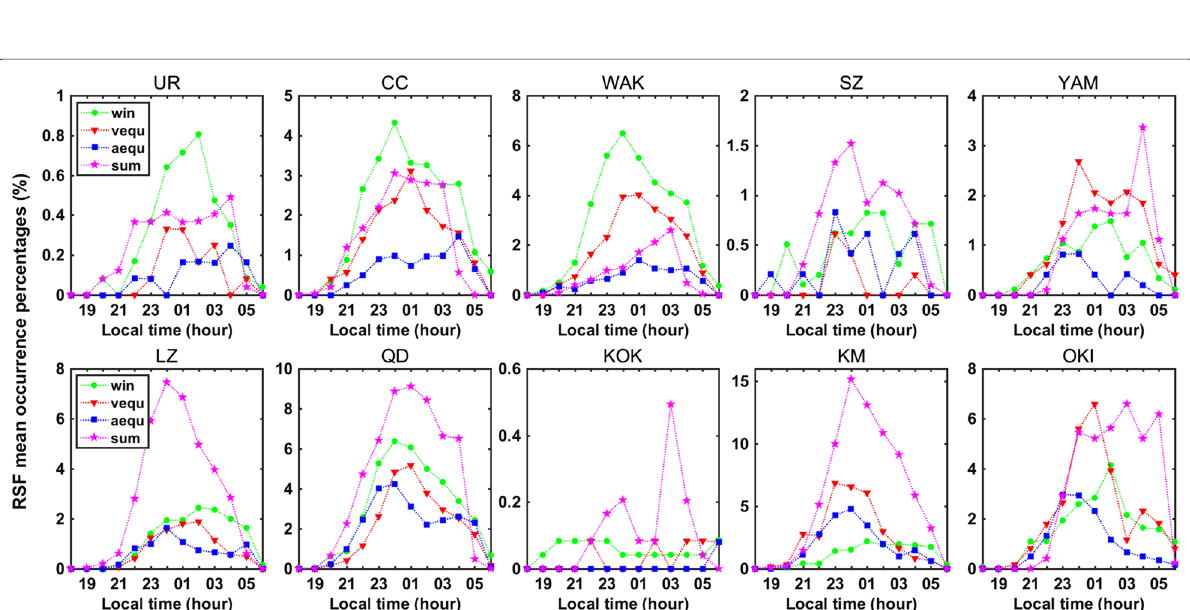
Fig. 11 Seasonal variations in RSF mean occurrence percentages; green, red, blue and magenta lines represent winter, vernal equinox, autumn equinox and summer,